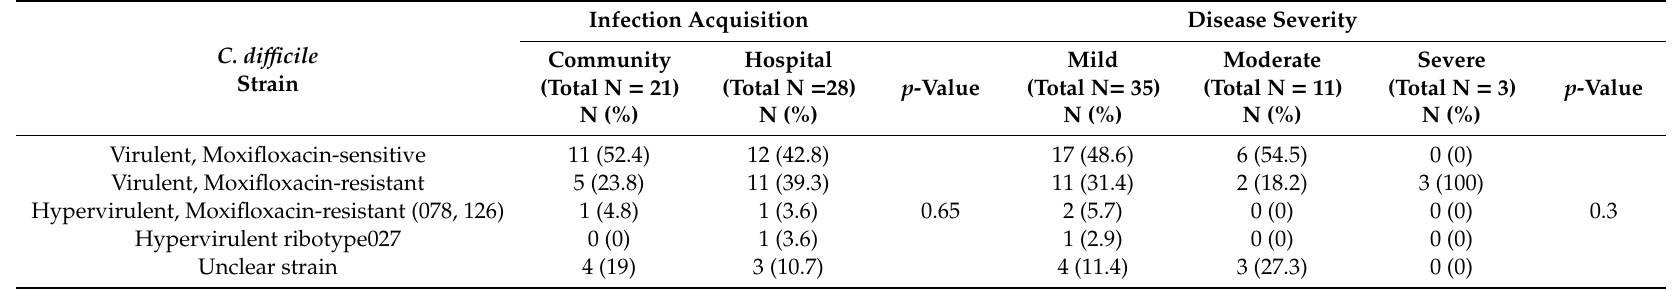
Table 2. Distribution of di ff erent C. di ffi cile strains in correlation with Infection Acquisition and Disease